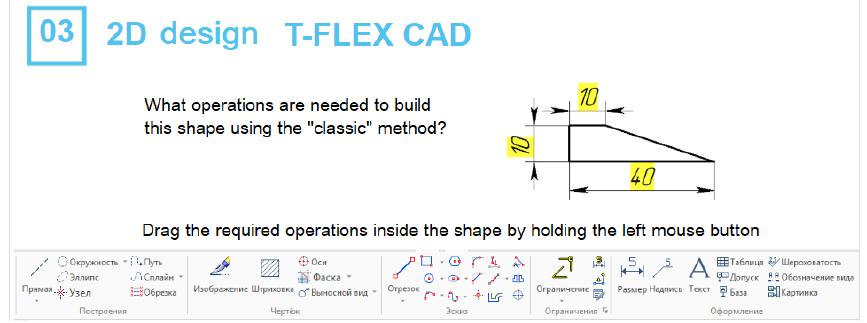
Fig. 10. “Drag and drop” task.